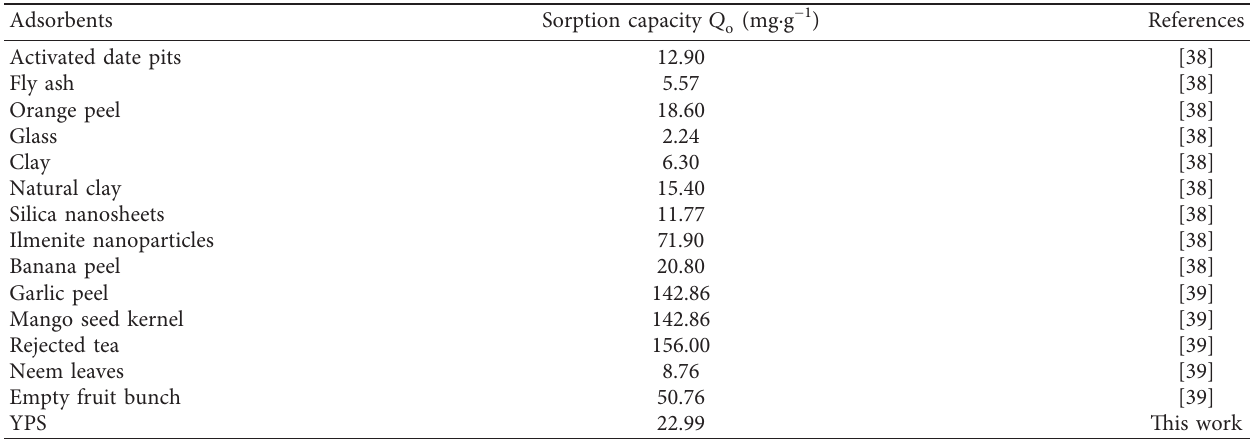
Table 16: Comparison of adsorption capacity of several low-cost adsorbents for the uptake of methylene blue from aqueous solutions.